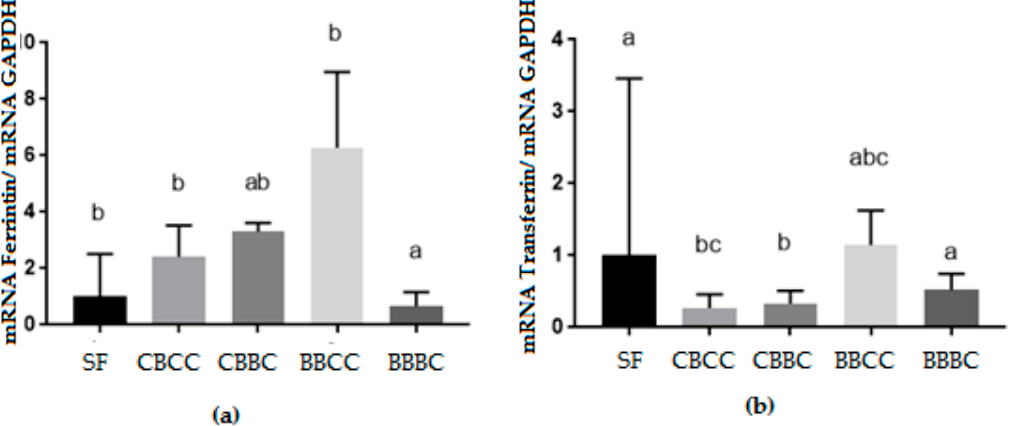
Figure 1. ( a ) Biomolecular analysis of ferritin mRNA, ( b ) Biomolecular analysis of transferrin mRNA. SF:Ferrous sulfate; CBCC:Conventional beans + conventional cassava; CBBC: Conventional beans + biofortified cassava; BBCC: Biofortified beans + conventional cassava; BBBC: Biofortified beans + biofortified cassava. Means followed by the same letter in the bars do not differ from each other ( p > 0.05).